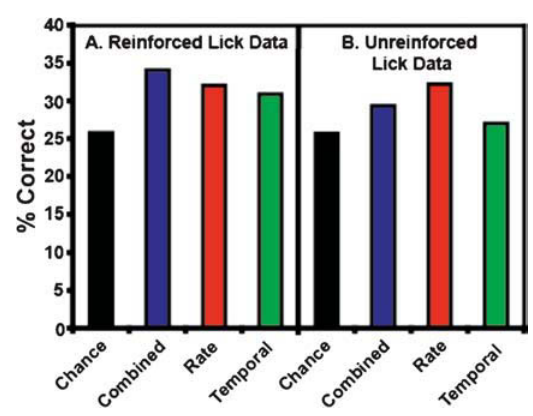
Figure 6. Total tastant classifications. Depicted above are the percentages of correct classifications across all tastant categories. (A) This panel presents the total percentage of correct classifications for the reinforced lick data. All threemodelsclassifiedthetastantsintocategoriesregardlessofconcentration above chance, but the combined model demonstrates the best performance. (B) This panel depicts the total percentage of correct classifications for the unreinforced lick data. Again, all three models classify tastants above chance, but the rate model exhibited the best performance.